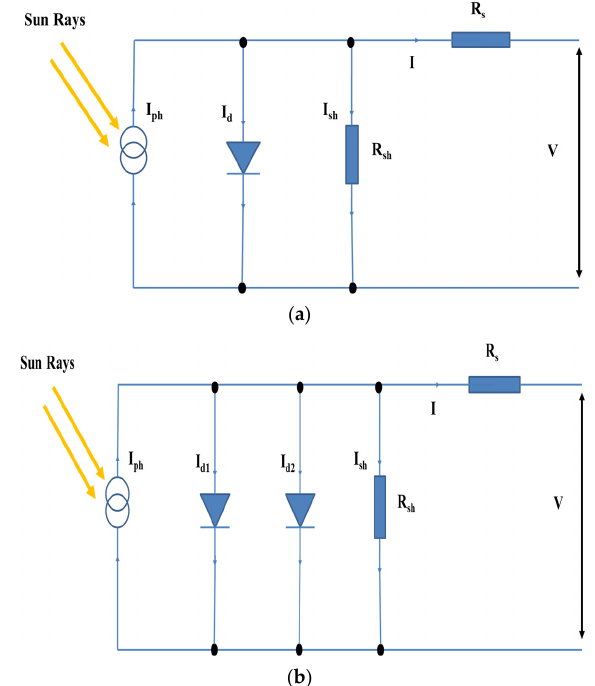
Figure 1. Equivalent circuits of the photovoltaic cell: ( a ) SDM model; ( b ) DDM model.